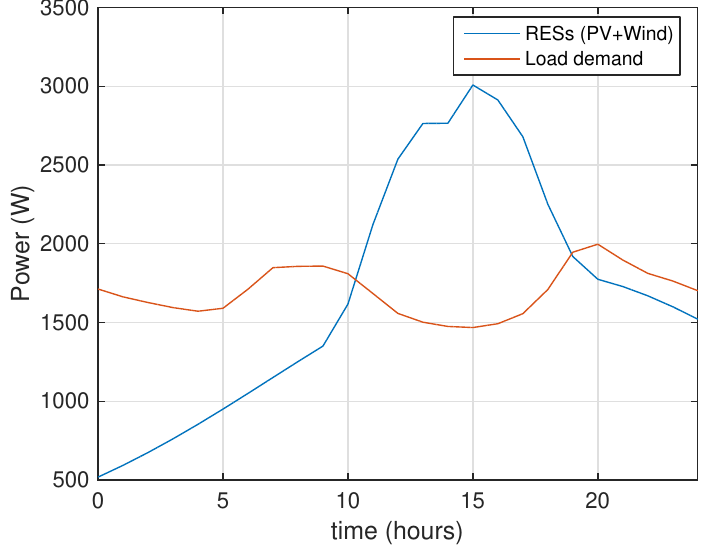
Figure 11. Power profiles for testing: RES generation (wind + PV) and load power